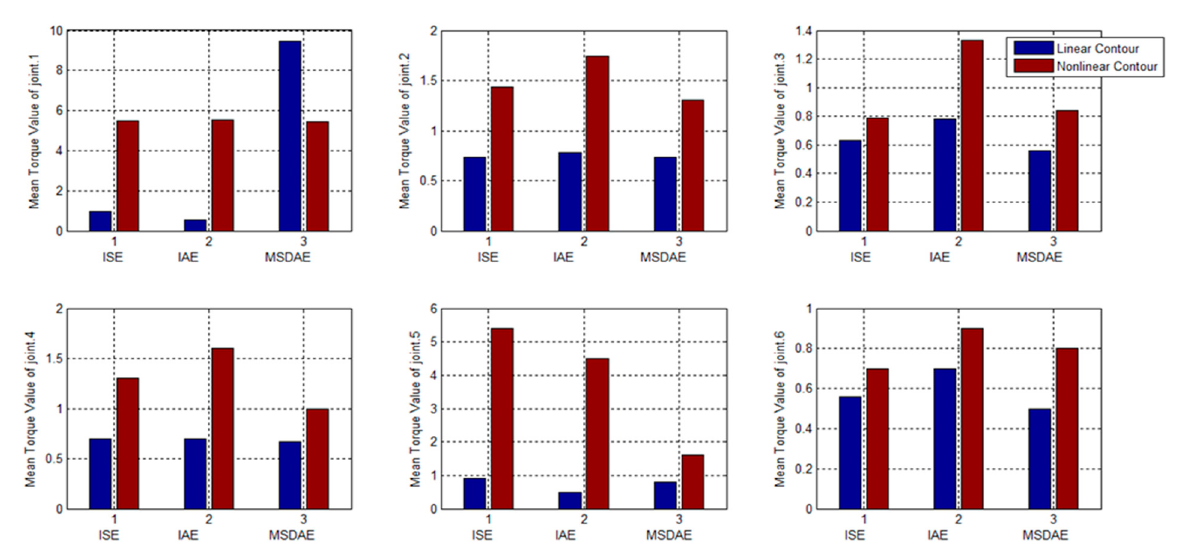
Figure 8. Mean torques required in linear and non-linear tracking.